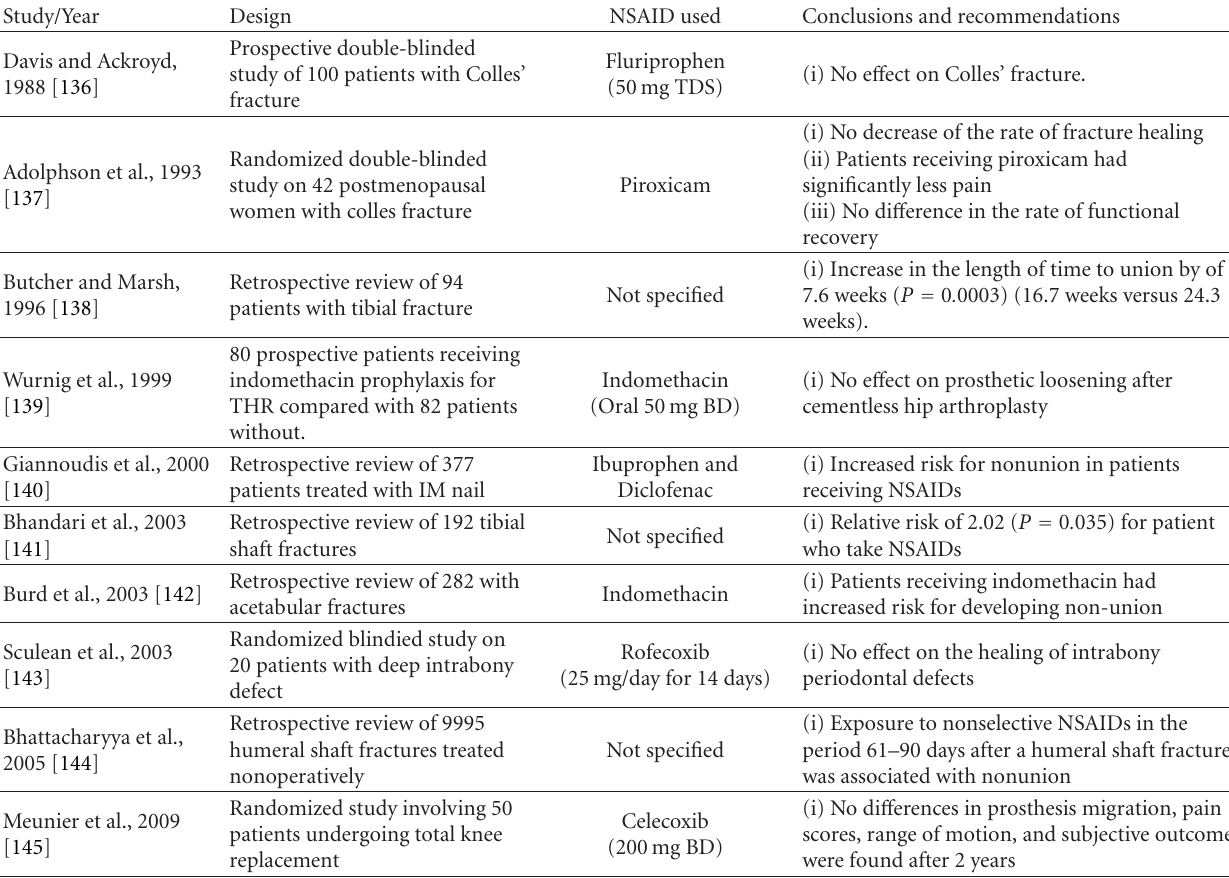
Table 4: Studies analyzing the e ff ect of NSAIDs on bone healing in